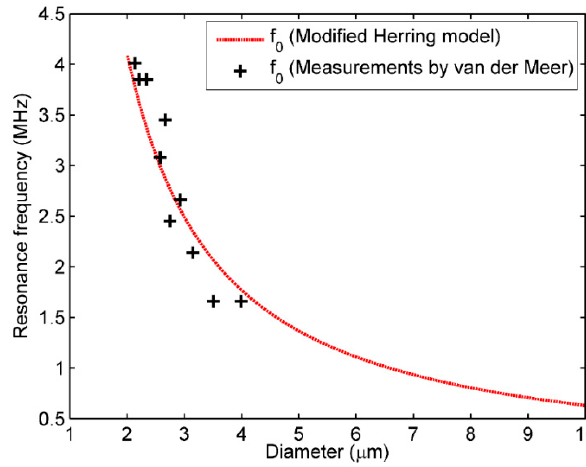
Figure 20. The resonance frequency of a SonoVue microbubble as a function of its diameter.